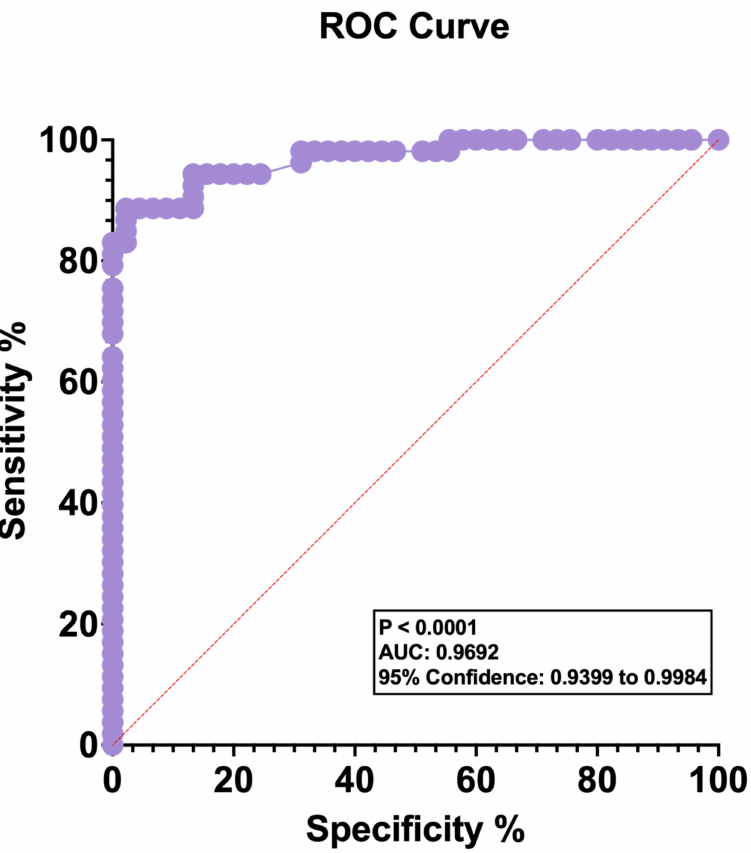
Figure 2. Receiver operating characteristic (ROC) plot. Patients with ovarian cancer (OvCa): n = 53; healthy female controls: n = 45. Area under the curve (AUC): 0.9692. The 95% confidence measuring between 0.9399 and 0.9984, p < 0.0001.